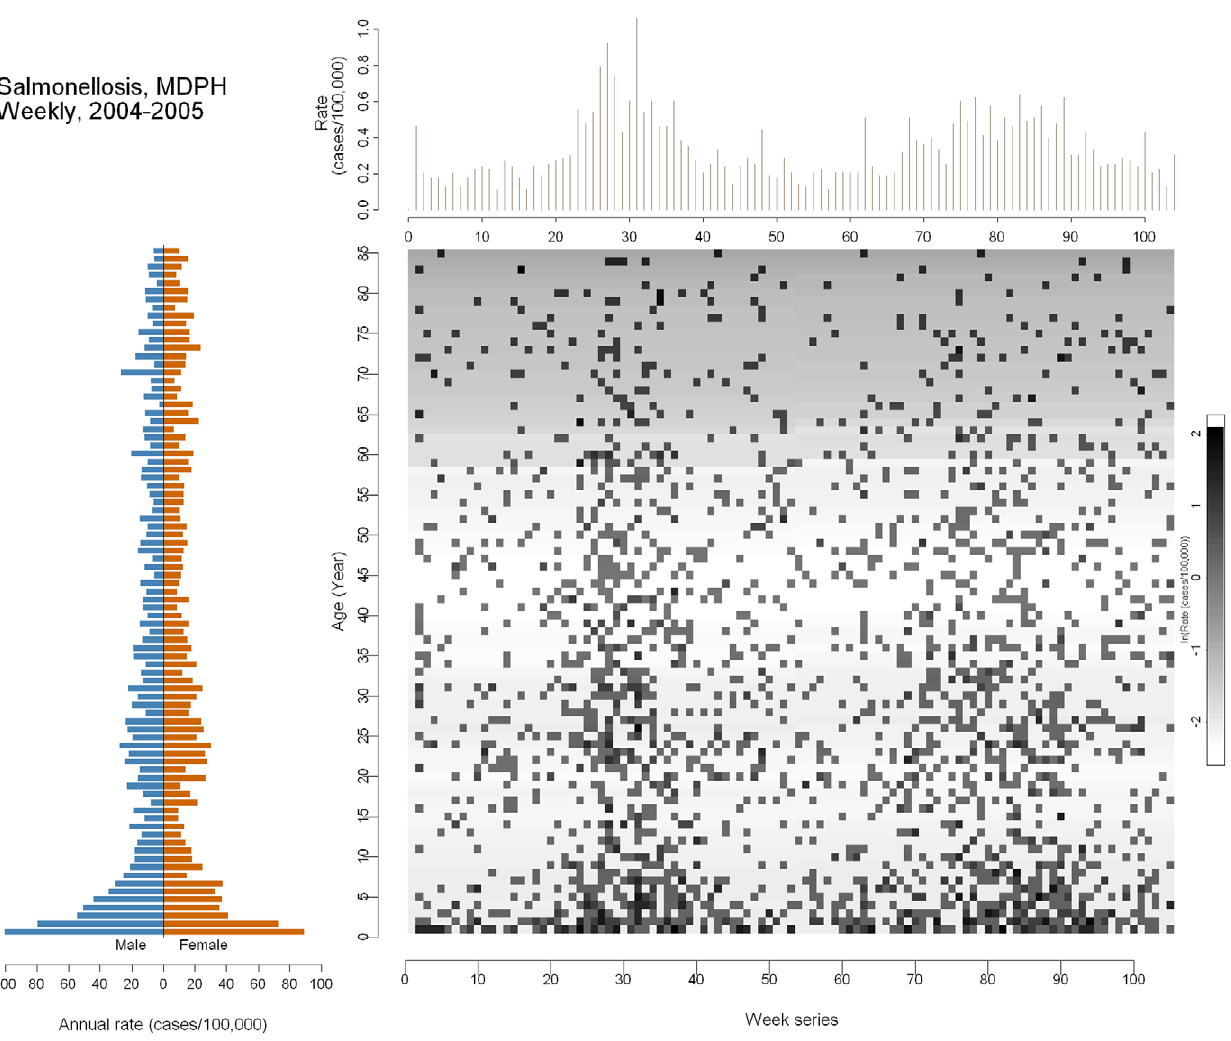
Figure 4. Multi-panel graph of salmonellosis in the general Massachusetts population 2004–2005. Lower left: outcome pyramid; upper right: time-series plot; lower right: image